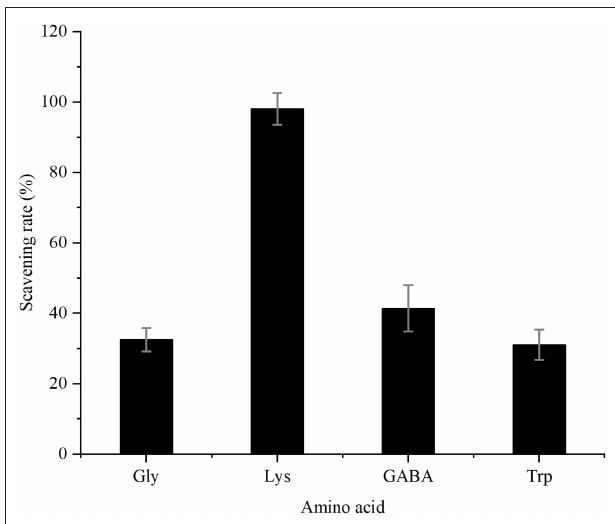
FIGURE 1 | Scavenging capacity of four amino acids for